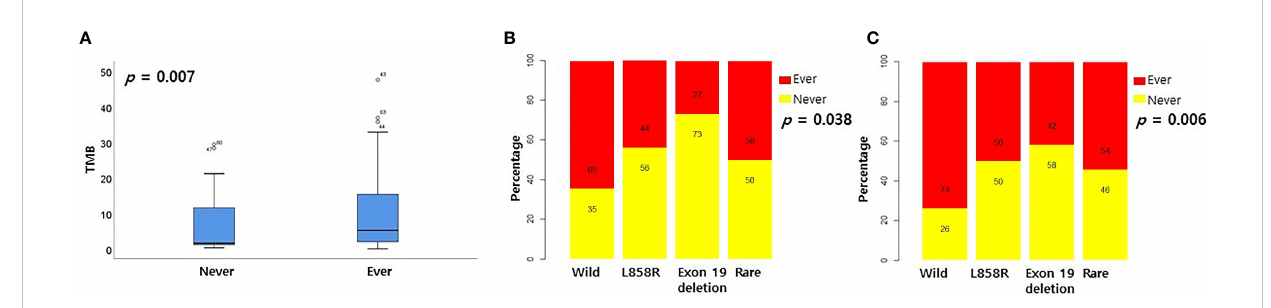
FIGURE 5 Relationship between smoking history and EGFR mutational subtypes. (A) Relationship between smoking history and TMB in cptac dataset. Relationship between smoking history and EGFR mutational subtypes in cptac (B) and validation (C) dataset.